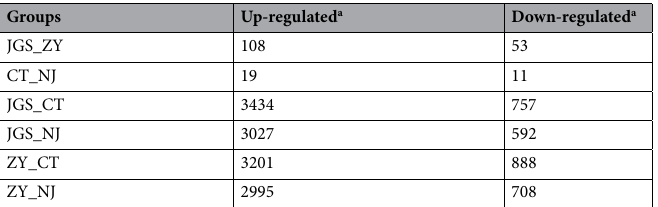
Table 3. The number of up-regulated and down-regulated DEGs between four geographic spongy moth strains. JGS Jingeshan, ZY Zunyi, CT Connecticut, NJ New Jersey. a Numbers refer to the quantity of up- or down-regulated DEGs in the first strain listed in each pairwise comparison relative to the second